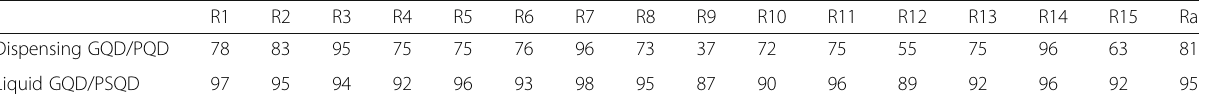
Table 1 The values of CRI No. 1 to No. 15 (R1 – R15) and CRI of the dispensing and liquid-type warm white and neutral white QD LEDs R1 Dispensing GQD/PQD